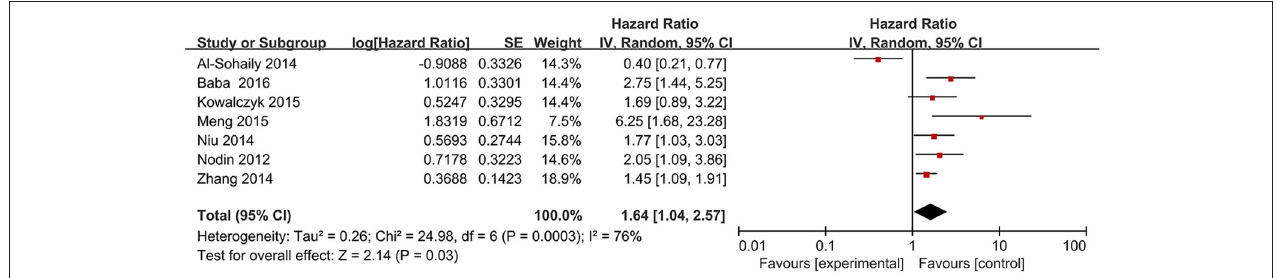
FIGURE 2 | Forest plot of HR for the association between SATB1 expression and OS in CRC. OS, overall survival; CRC, colorectal cancer; HR, hazard ratios.